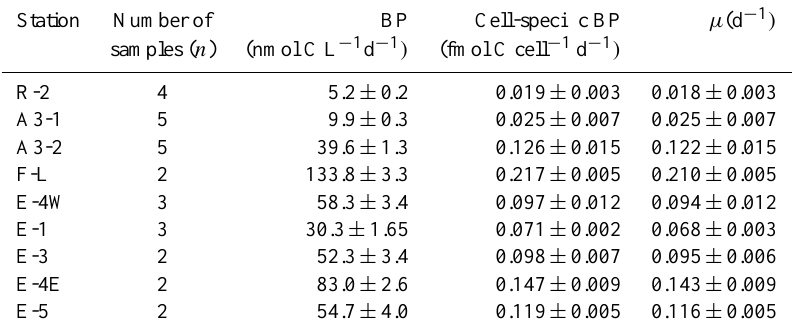
Figure 3. Distribution of the abundance of virus (VLPs – virus-like particles), heterotrophic bacteria (HB), and heterotrophic nanoflagellates (HNF) along the north–south (TNS) and east–west transects (TEW; cf. Fig. 1) of KEOPS2. The red vertical line “PF” denotes the position of the polar front. Table 4. Bacterial production, cell-specific bacterial production, and bacterial growth rates in surface waters. Mean values ± SD for the mixed layer are given. Station Number of BP Cell-specific BP µ (d − 1